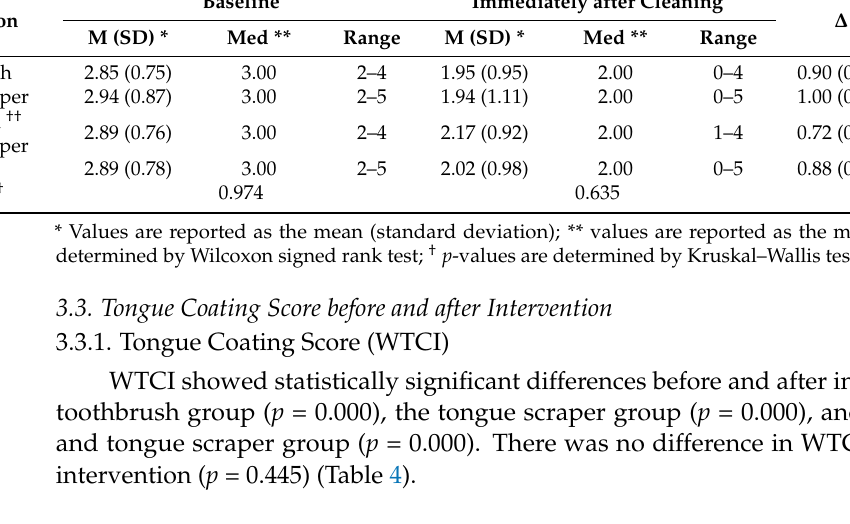
Table 4. Tongue coating score (WTCI).